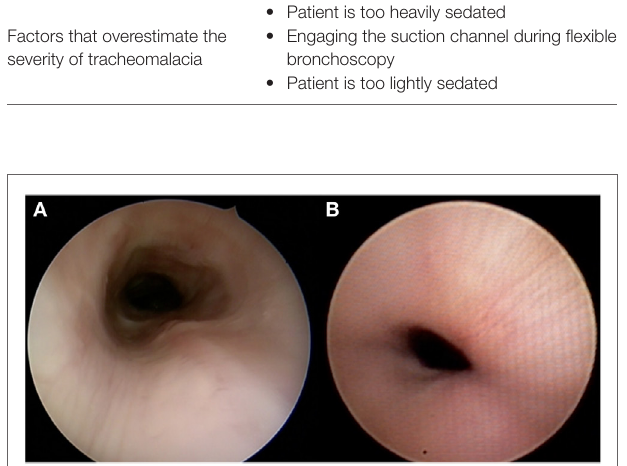
FiGURe 2 | Different appearances of tracheomalacia as seen with rigid bronchoscopy using a telescope only (A) and flexible bronchoscopy (b) .